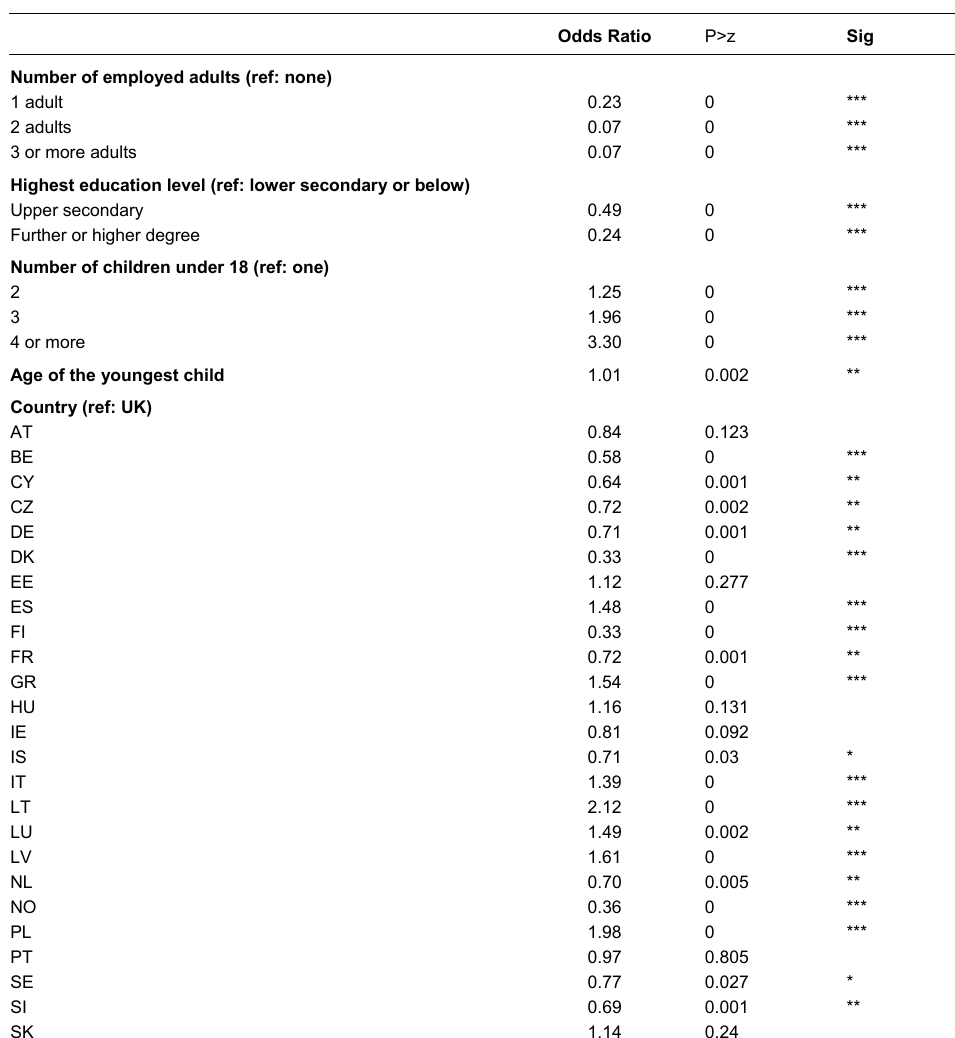
Table 1 : Logistic odds of a child being poor